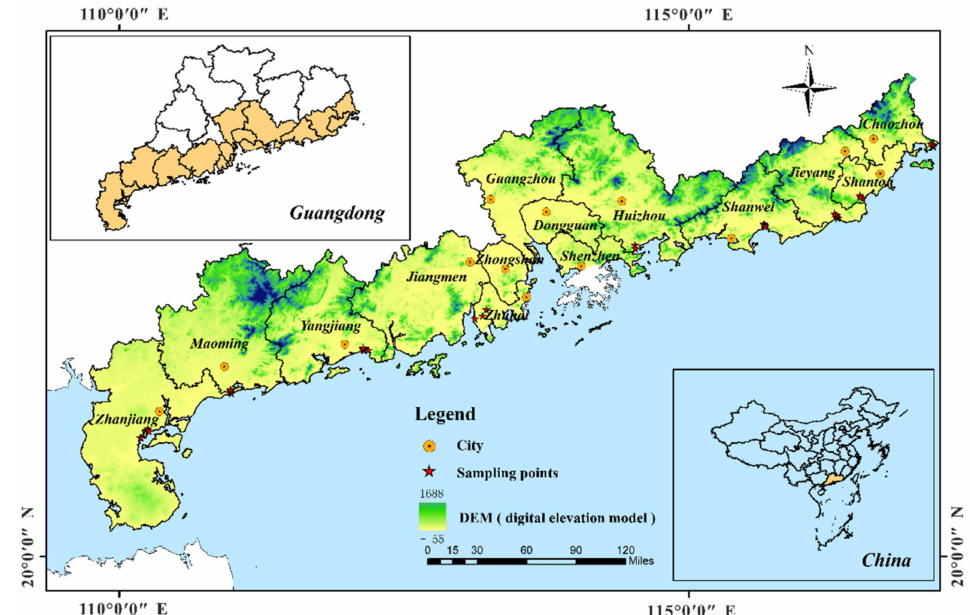
Figure 1. Sampling sites in Guangdong. The sampling points include all the cities along the coast of Guangdong: Zhanjiang, Maoming, Yangjiang, Jiangmen, Zhongshan, Guangzhou, Dongguan, Shenzhen, Huizhou, Shantou, Jieyang, Shantou, and Chaozhou. The top left image is a map of the coastal region of Guangdong Province, with the coastal cities highlighted. The bottom right image is a map of China, with the study area of Guangdong